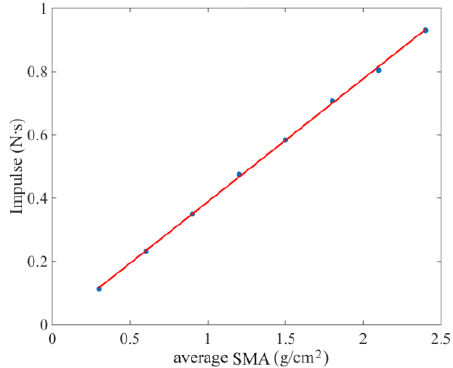
Figure 4. Linear relationship between κ 0 and I .